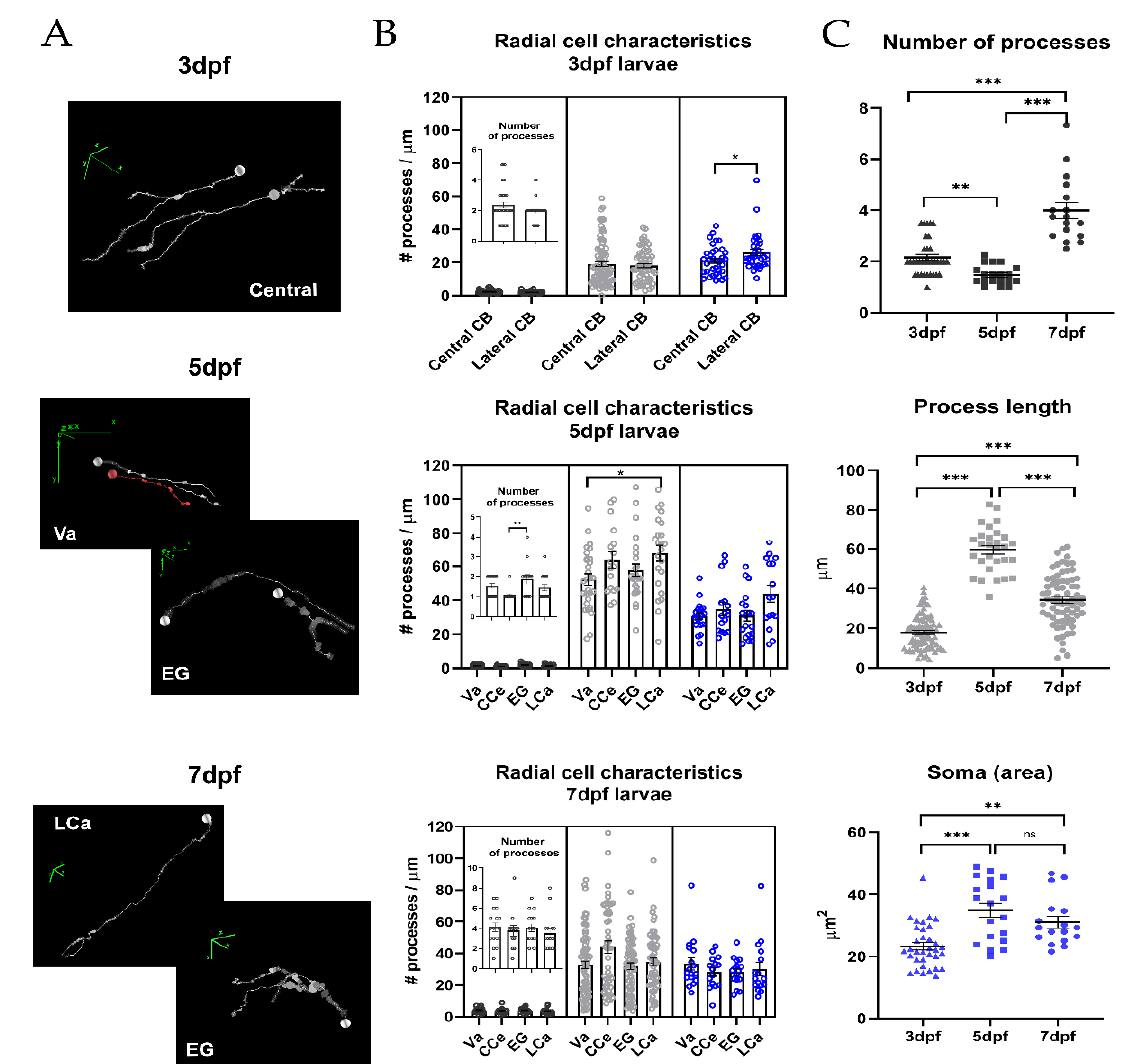
Figure 2. Morphometric characteristics of radial glia during cerebellar development. ( A ) Representative 3D reconstructions of radial glia randomly selected from different regions at 3, 5 and 7 dpf. The concentric rings along the process represent the spatial orientation and thickness of the process; in these representations, nuclei are indicated by a sphere, the processes in white and red lines and direction of the axis (x, y and z, green lines) ( B ) Nested graph showing the number (black dots), length (gray dots) of processes and soma area (blue dots, inset) in the different cerebellar regions at 3, 5 and 7 dpf (Va, CCe, EG and LCa; N = 5–7 larvae per stage). For simplification, only statistically significant differences are presented; cell somas at 3 dpf: central vs. lateral, 21 ± 1.5 µ m 2 vs. 26 ± 2.0 µ m 2 , Mann–Whitney U test, ( p -value 0.049 *, α 0.05), process length at 5 dpf: Va vs. LCa, 52.3 ± 3.3 µ m vs. 67.7 ± 4.7 µ m, ANOVA-Tukey ( p -value 0.0309 *, α 0.05). ( C ) Graphs comparing the characteristics of radial glia from the whole cerebellum between the three ages evaluated (Kruskal–Wallis Test, Dunn’s post hoc, α 0.05, p -value: 0.1 (ns), 0.05 *, 0.01 **, <0.001 ***), graphs show mean ± SEM (see Table 2 for descriptive statistics).